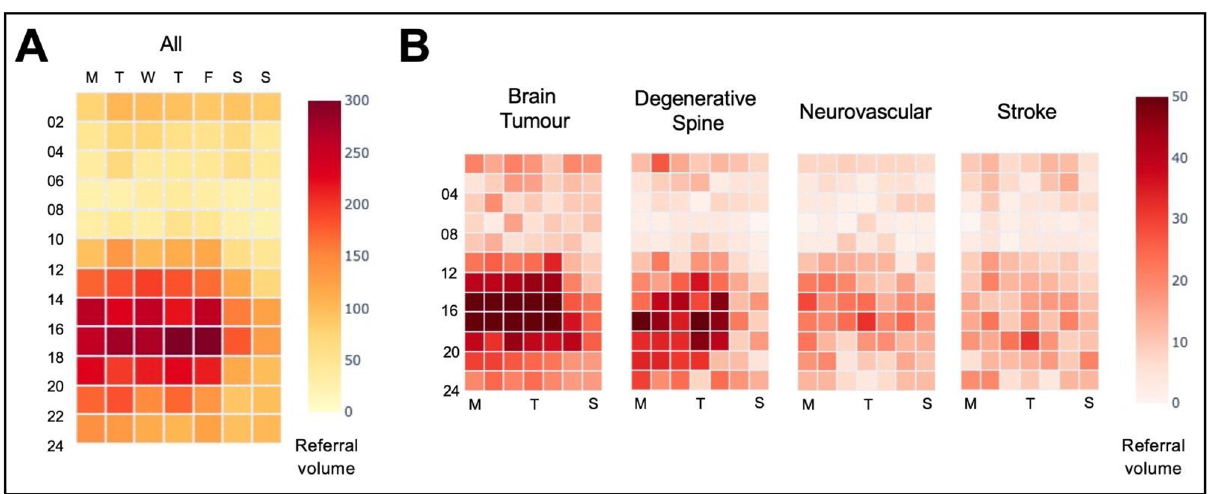
Figure 5. Referral heatmap. Referral volumes sorted by day and time for all ( A ) and for the four highest referring diagnostic categories ( B